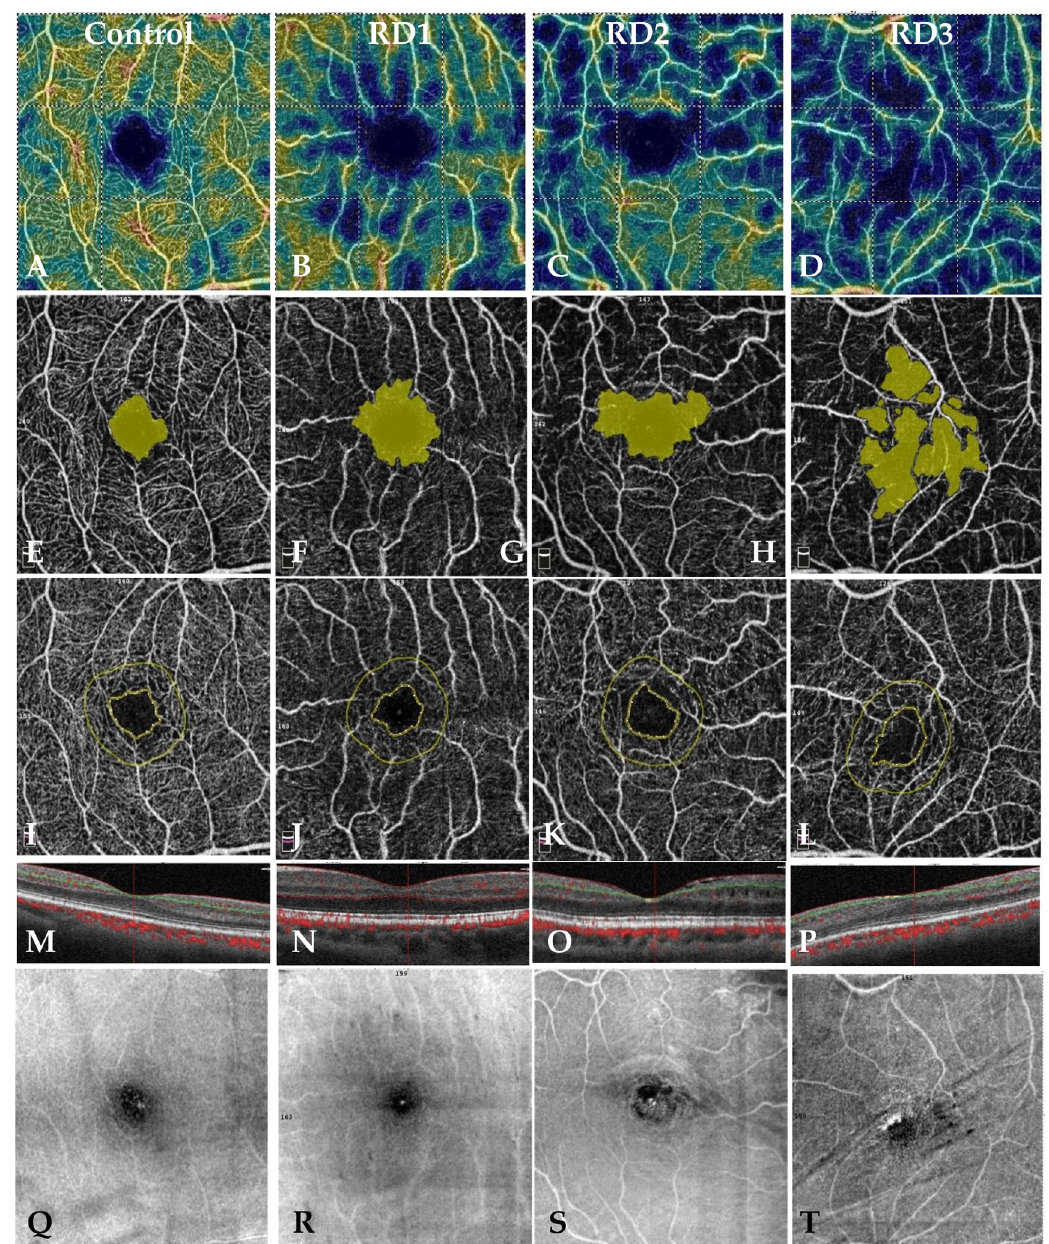
Fig 3. Demonstrative OCT-A images from all groups. VD—Vessel density (A-D). Non-flow area (E-H), FAZ—Foveal avascular zone (I-L), OCT image (M-P), and en face image